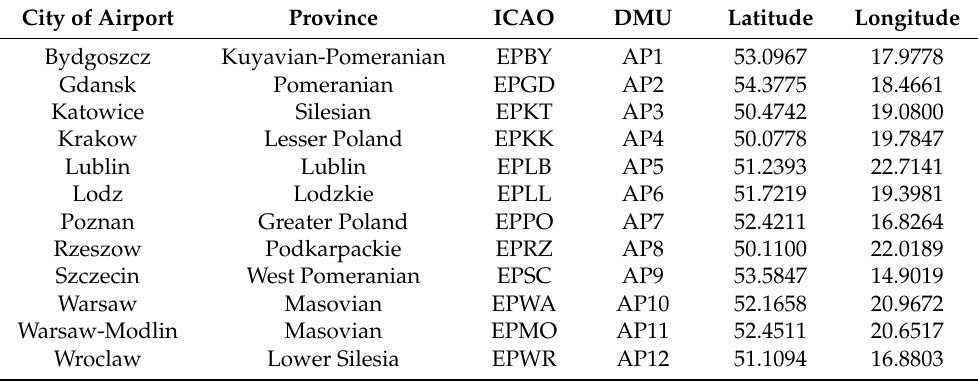
Table 1. Polish airports in the analysis; their codes by ICAO and DMU.